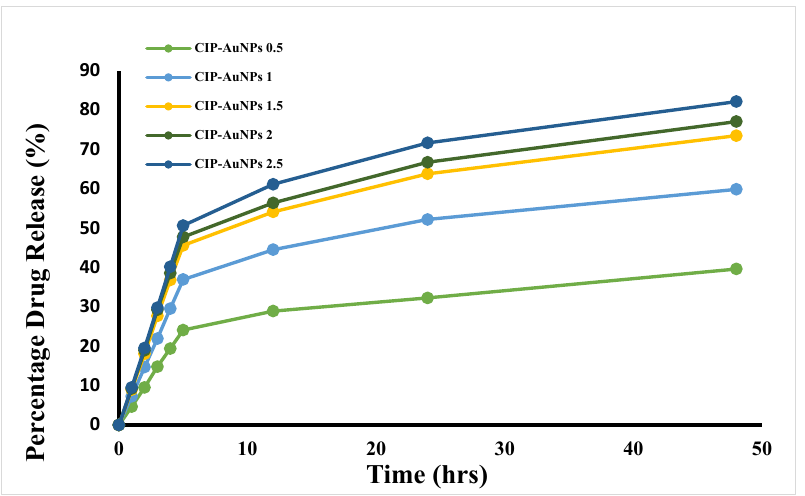
Figure 5. In vitro CIP release from AuNPs loaded with various CIP concentrations.